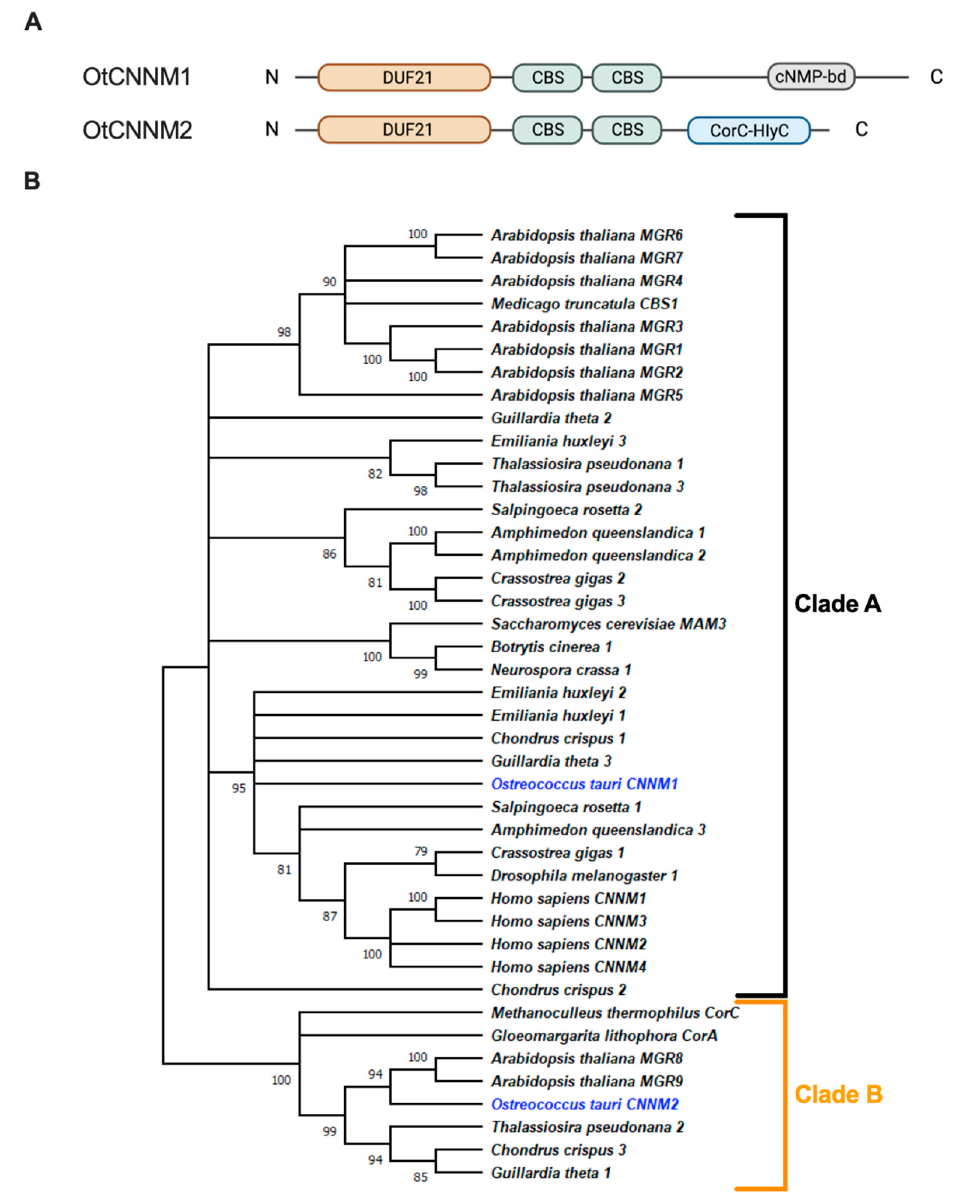
Figure 1. Structure and ancestry of two Ostreococcus CNNM proteins (marked blue). ( A ) Schematic diagram of the structure of the CNNM proteins found in Ostreococcus tauri . ( B ) Maximum likelihood (ML) phylogenetic tree (100 bootstraps) of whole protein sequences for CNNM homologs.